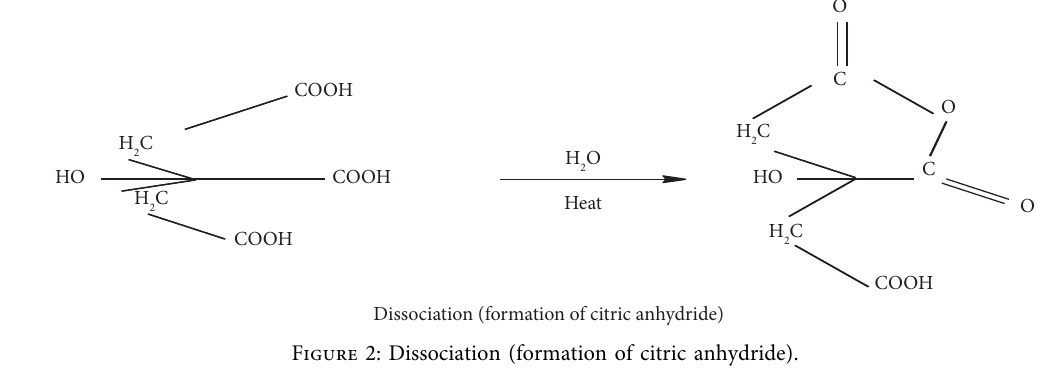
Figure 2: Dissociation (formation of citric anhydride).